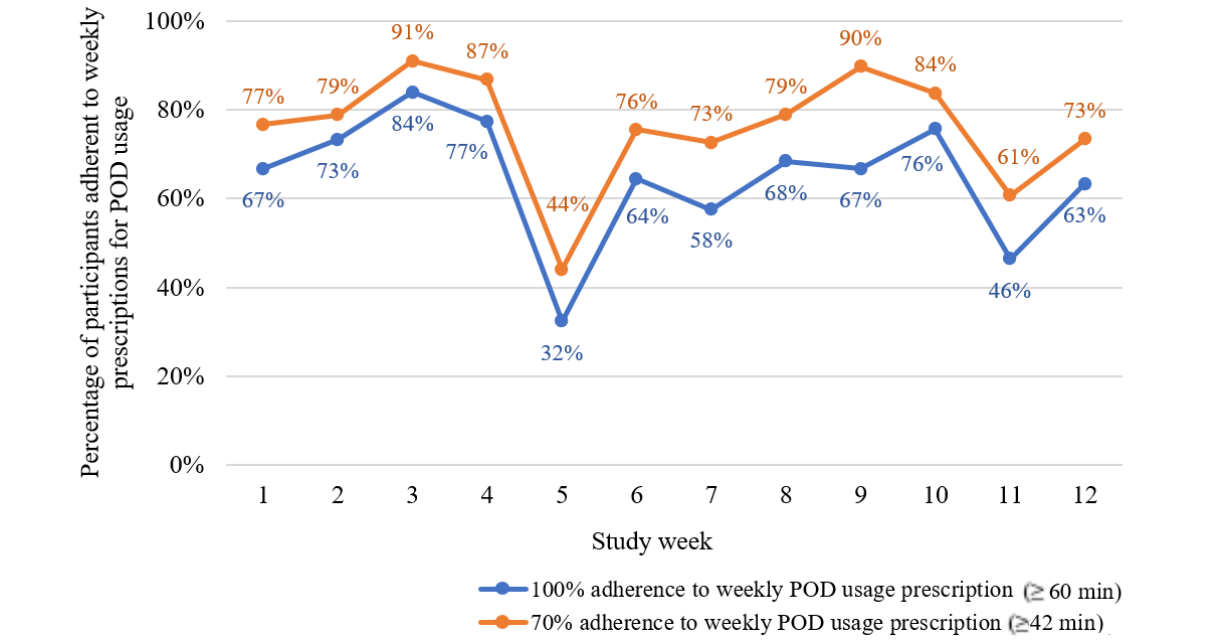
Figure 6. Percent adherence to prescribed podcast app use by